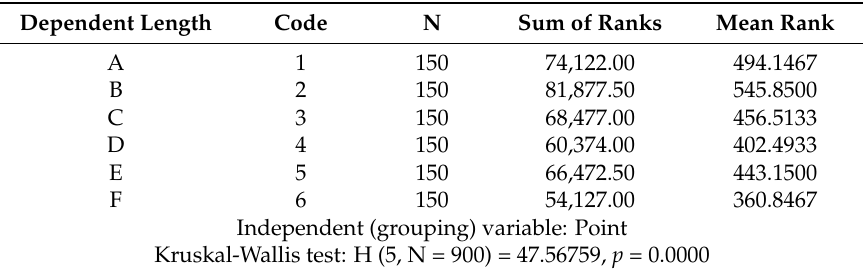
Table 4. Kruskal-Wallis test results for length